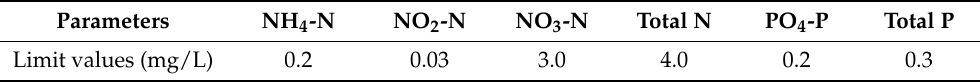
Table 2. Limit values ( Si ) in surface waters for the class of good environmental status [72].